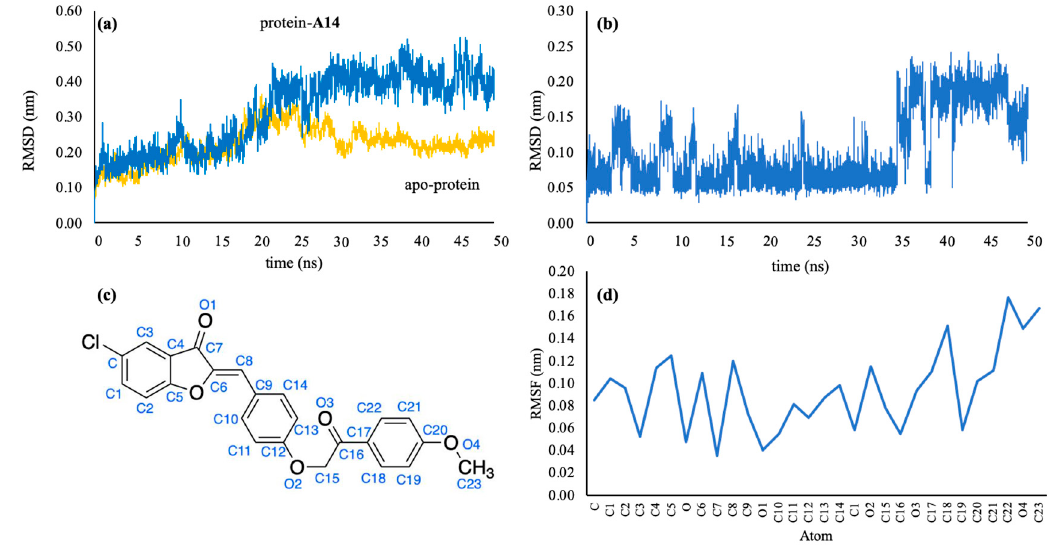
Figure 10. Stability of ligand A14 in protein ‐ A14 during 50 ns molecular dynamics (MD) simulations. ( a ) Root mean square deviation (RMSD) values of 1LPB protein in apo ‐ protein and protein– A14 complex; ( b ) RMSD values of ligand A14 in protein– A14 complex; ( c ) 2D structure of A14 with atomic numbering; and ( d ) Root mean square fluctuation (RMSF) heavy chain atoms of ligand A14 .